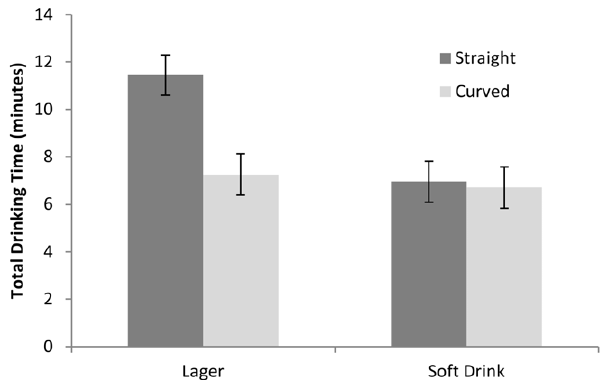
Figure 2. Total Drinking Time for Full (12 fl oz) Volume by Drink and Glass Type. Total drink time (minutes) for a 12 fl